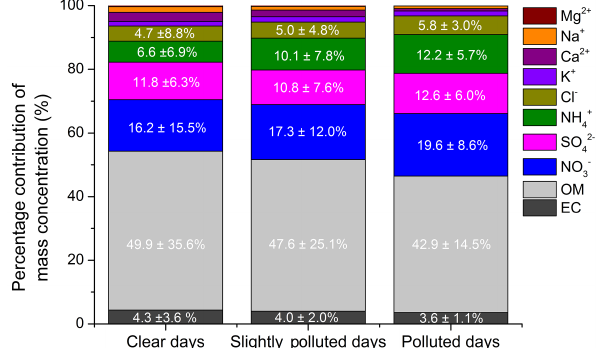
Figure 8. The percentage contribution of the mass concentrations of OM, EC concentrations and eight water-soluble ion components on clear, slightly polluted, and polluted